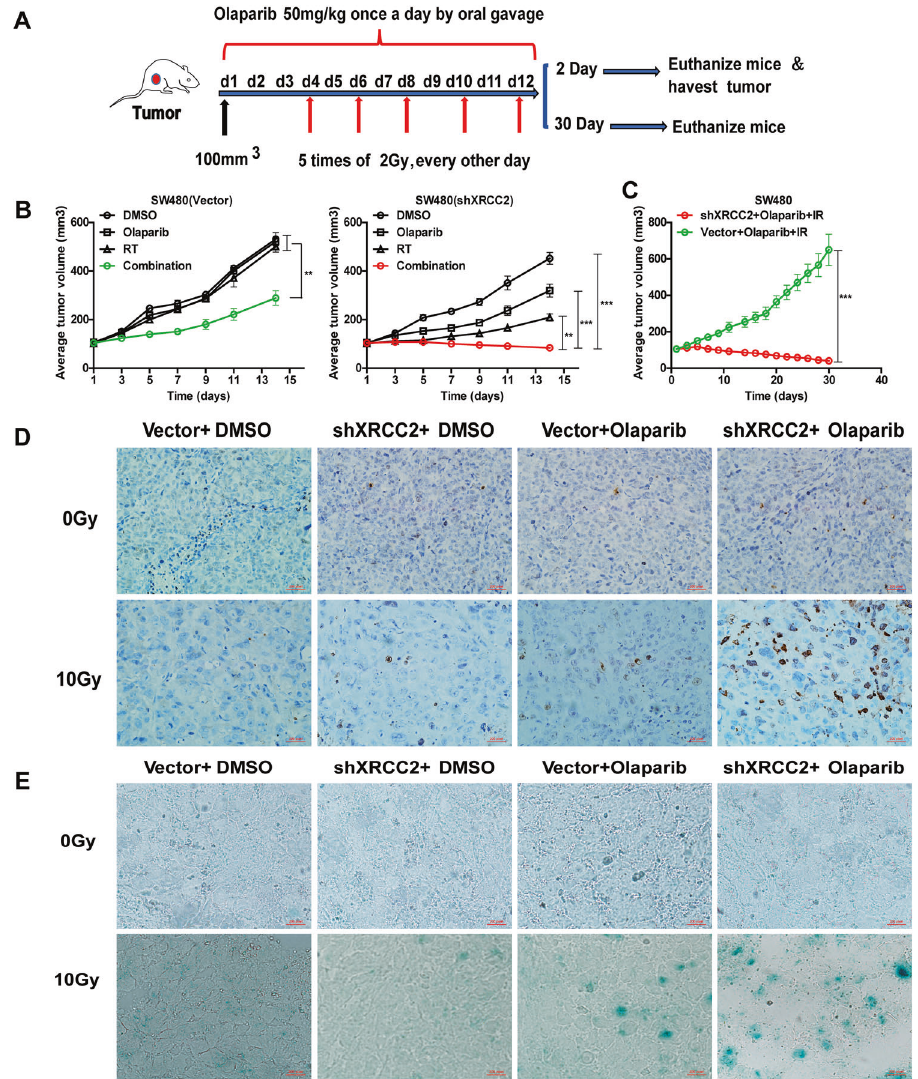
Fig. 6 Effect of olaparib and IR on growth and senescence of XRCC2 -de fi cient tumor xenografts in mice. A Experimental design. B Change of tumor volume over 2 weeks in the different groups that received SW480 cells with empty vectors (left) or shXRCC2 (right). Data are presented as means ± SEMs ( n = 5); ** P < 0.01, *** P < 0.001. C Change of tumor volume over 4 weeks in the two indicated groups. Data are presented as means ± SEMs ( n = 5); *** P < 0.001. D , E Representative immunohistochemical staining of γ -H2AX (top) and β -gal activity (bottom) in the different groups from tumors harvested 2 days after treatment with Olaparib with or without IR